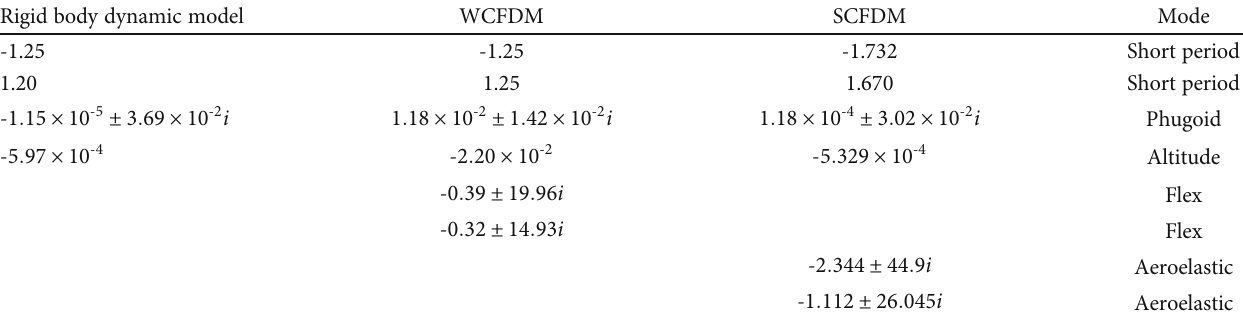
Table 2: Modal characteristics at Ma = 8 , H = 26 km